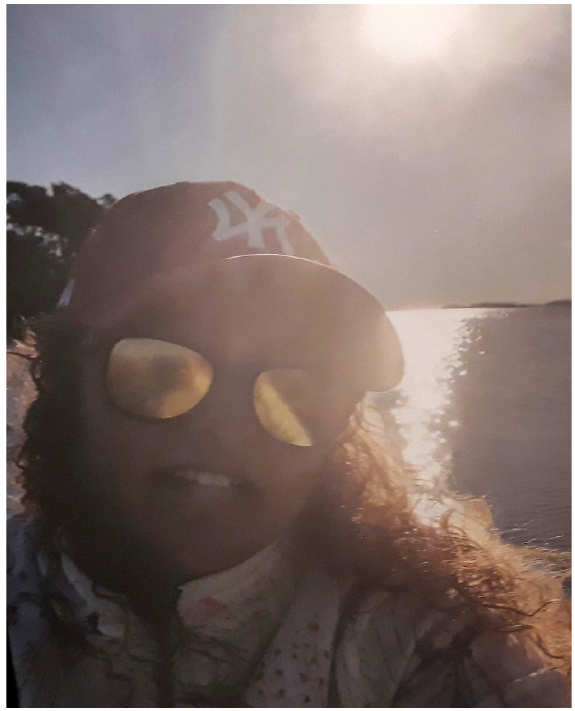
Figure 2. A hidden